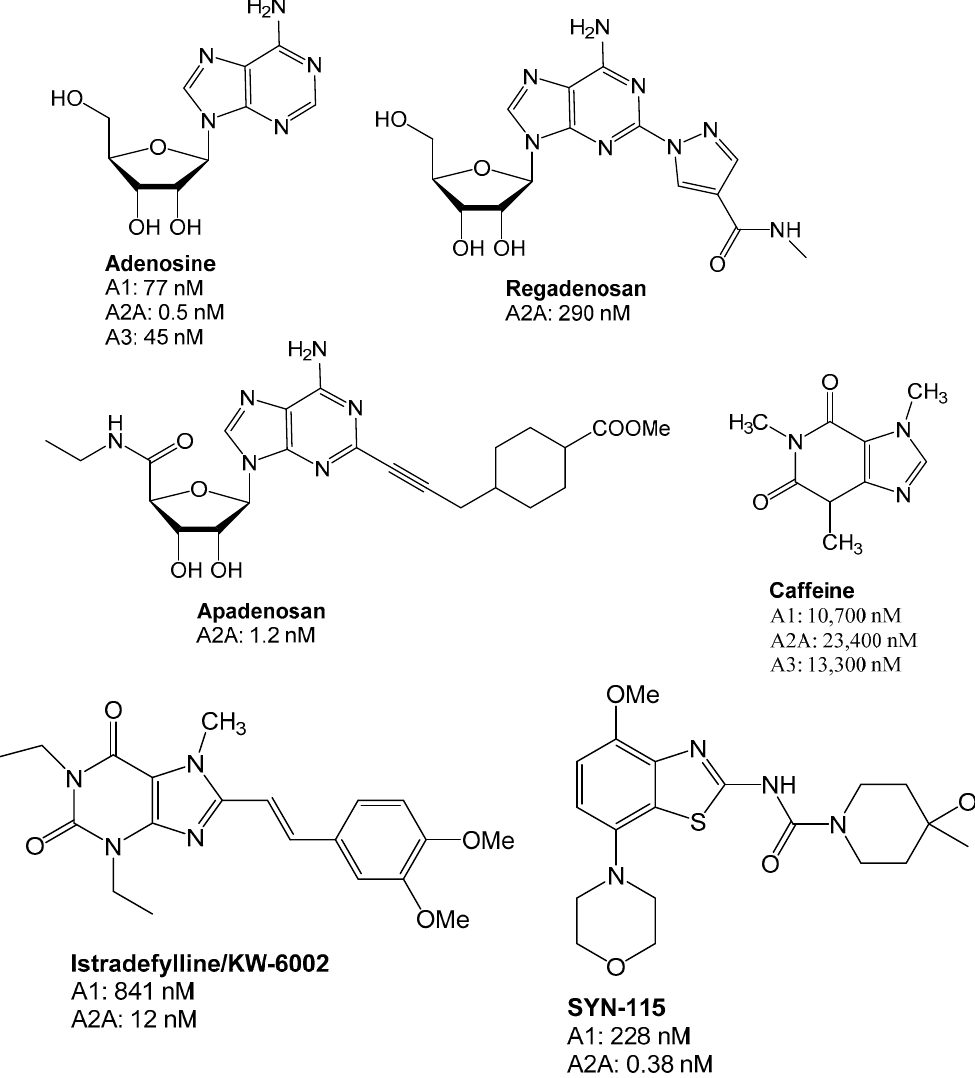
Figure 4. Structures of adenosine ligands which were evaluated in clinical trials. The therapeutic areas represented a range from cardiovascular to neurodegenerative diseases such as Parkinson’s disease [25]. For a more in-depth review, the reader is referred to a recent review [3].